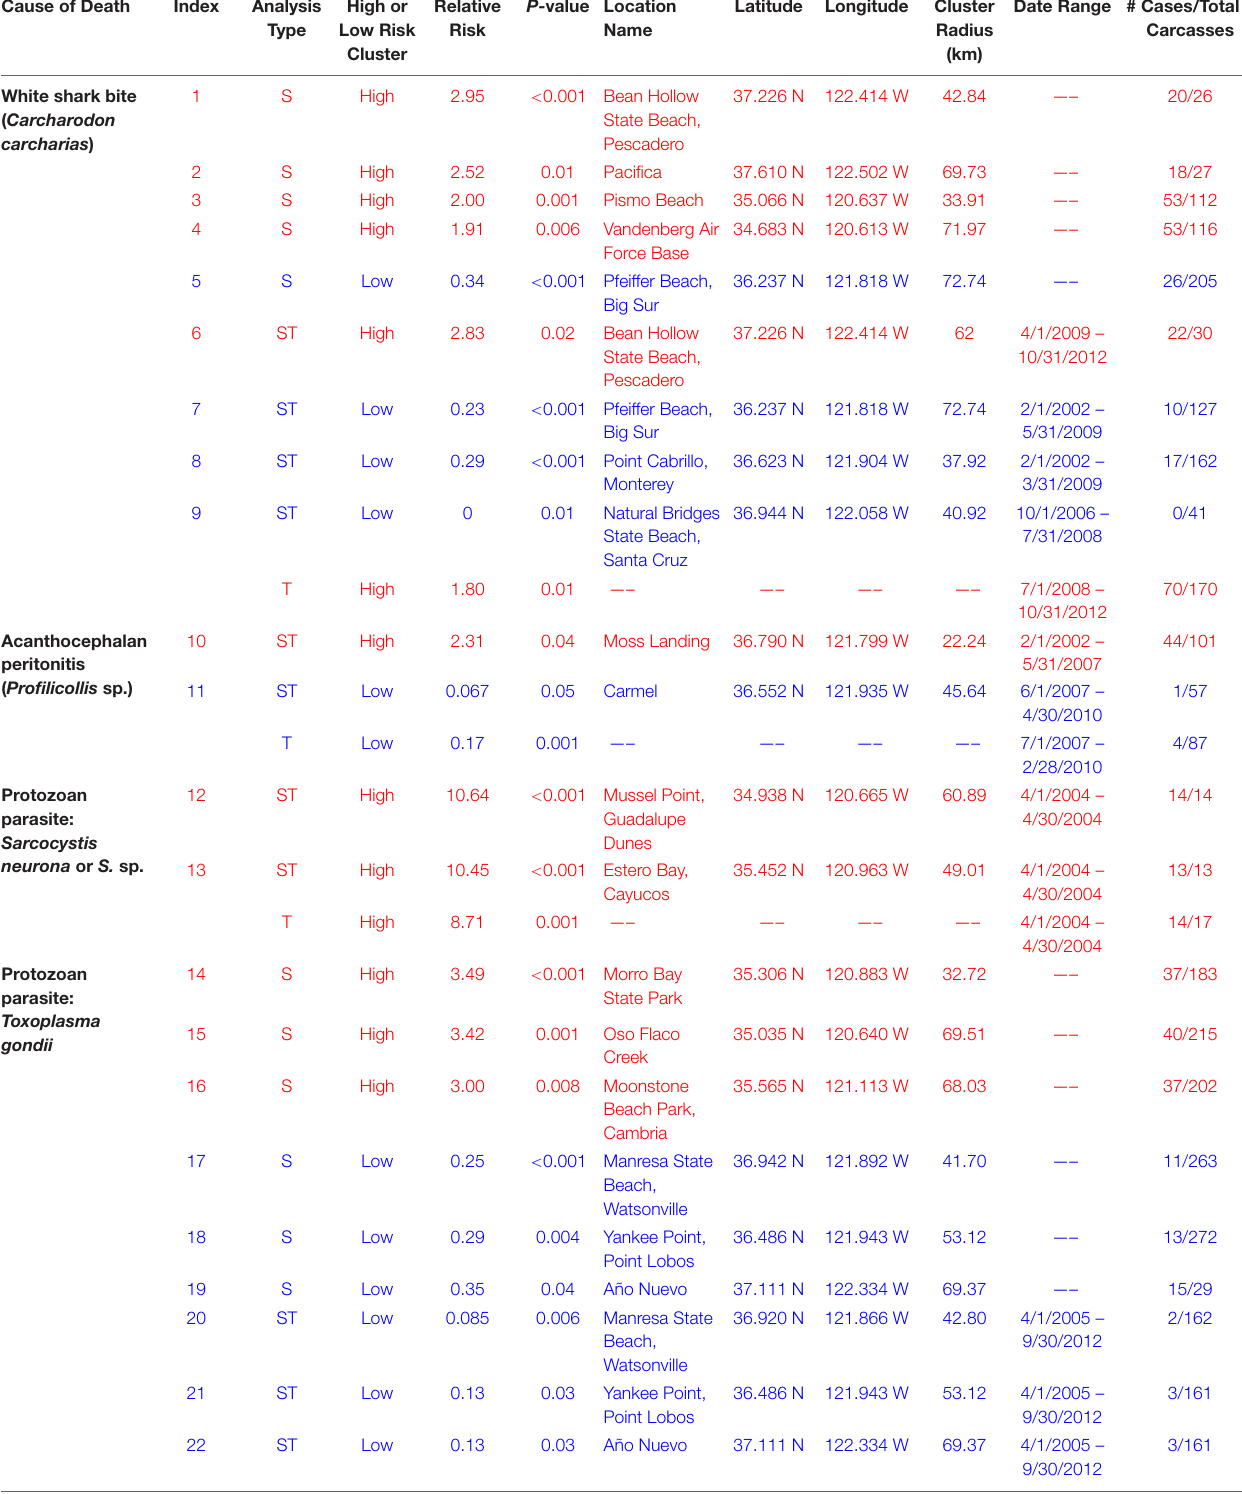
TABLE 3 | Spatial and temporal clustering patterns for stranded southern sea otters ( Enhydra lutris nereis ) in relation to key causes of death (COD), for 560 animals necropsied 1998–2012. Cause of